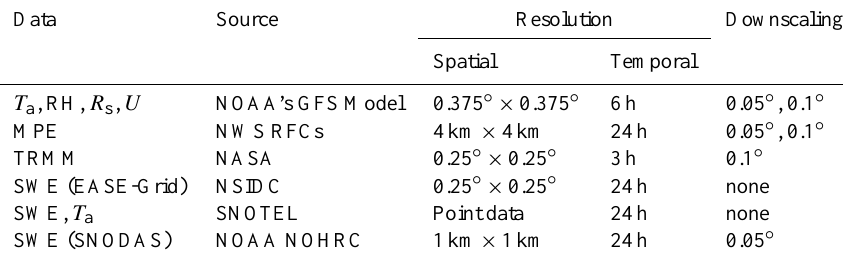
Table 3. Source and resolution of meteorological and snow